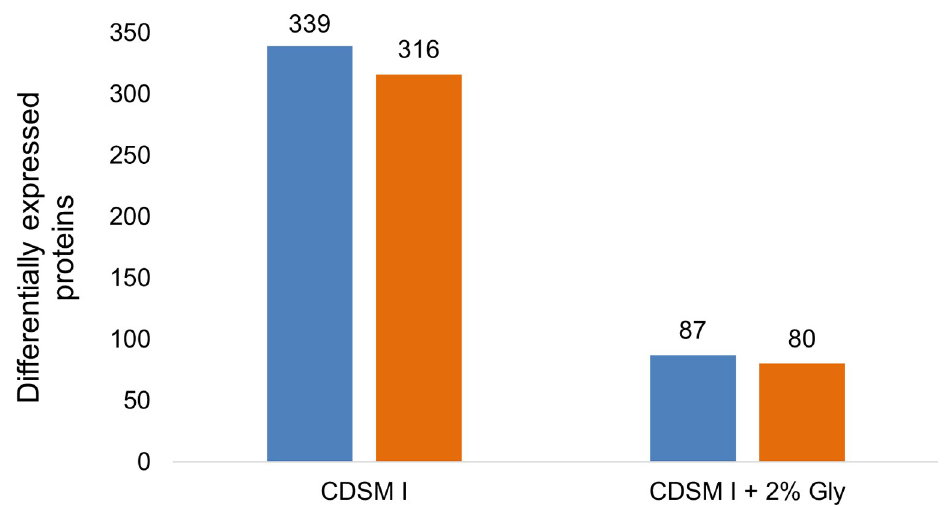
Fig 3. Number of statistically significant differentially expressed proteins compared to the baseline condition in LB media. Orange bars represent the number of downregulated proteins while blue represents all upregulated proteins compared to baseline LB media after a student’s t-test with an FDR of < 0.05.